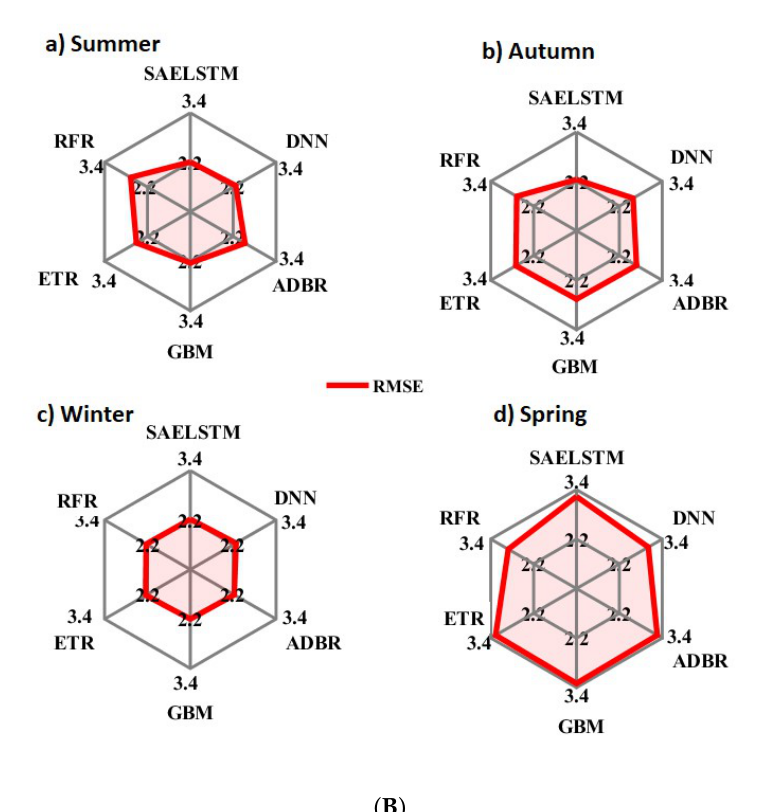
Figure 14. ( A ) Seasonal performance evaluation of proposed SAELSTM model compared to other artificial intelligence-based model in terms of WI , NSE , KGE , RRMSE (%), RMAE (%), and APB, (%). ( a ) Summer, ( b ) Autumn, ( c ) Winter, and ( d ) Spring. ( B ) Seasonal performance evaluation of proposed SAELSTM model compared to other artificial intelligence-based models in terms of RMSE . (Note: Names for each model are provided in Tables 3 and A1 in Appendix